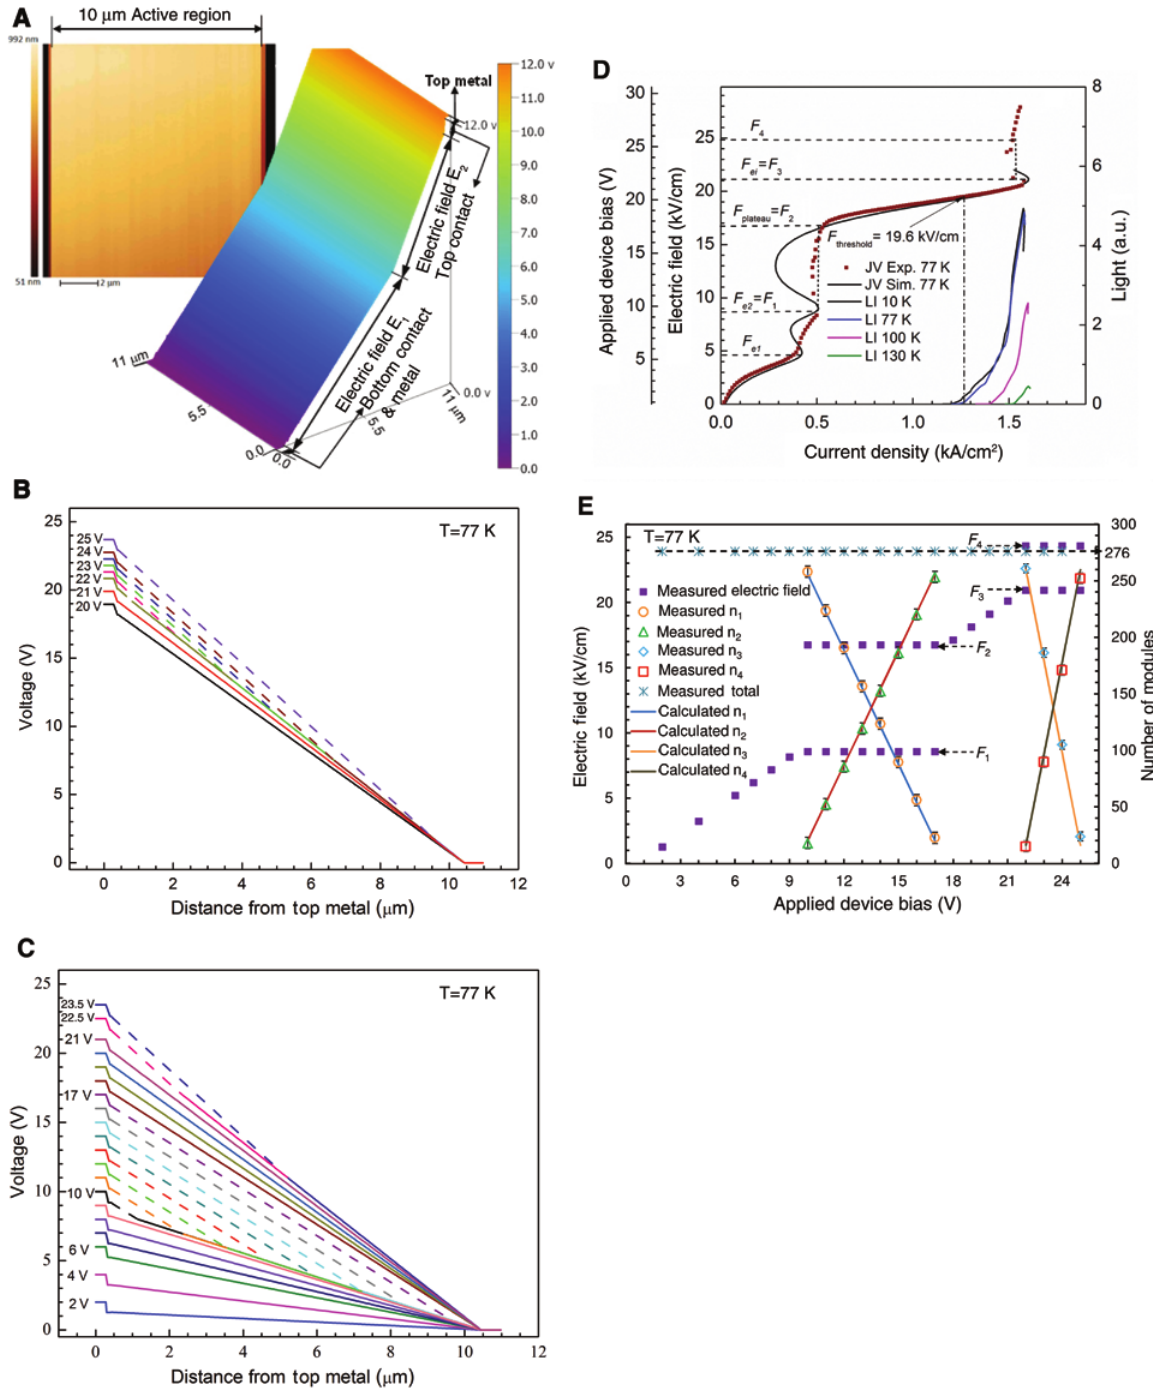
Figure 17: SVM results of an operating terahertz QCL (V843), showing the formation and evolution of EFDs in the active region. (A) An SVM- measured 2D voltage profile across V843 at a forward bias of 12 V (pulsed mode, 3.5 μ s pulse width, and 100 Hz repetition rate) at 77 K. Two EFDs ( F and F ) across the ~ 10- μ m-thick MQW active region are observed. The inset of the figure shows a 2D topology image over the same 1 2 area. (B and C) 1D voltage profile across the device active region at different biases (2–25 V). (D) Experimental and simulated electrical and optical characteristics of V843 at 77 K and other temperatures (10, 50, 100, and 130 K). (E) The SVM-measured electric field across indi- vidual cascade modules in the active region of operating V843 device as a function of applied device bias. In the bias ranges of 10–17 V and 22–25 V, the active region splits to two EFDs and the electric field in each EFD remains constant. Shown together is the partition number of the cascade modules in each EFD measured from SVM. The number of cascade modules in the higher EFD increases, while the number of cascade modules in the lower EFD decreases with the device